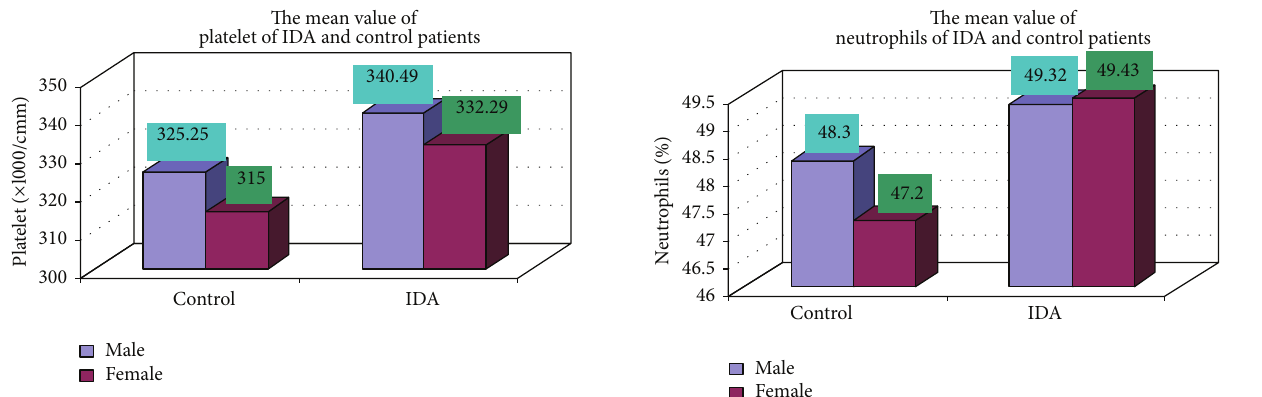
Figure 15: Showing mean value of neutrophils of control and iron deficiency anemia.